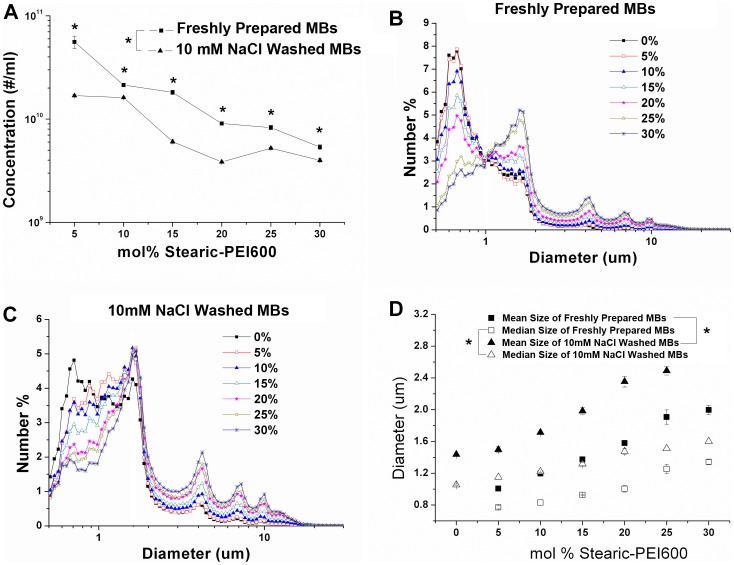
Concentration and size distribution of fresh prepared and washed MBs.(A) Concentrations of freshly prepared and washed MBs with various amounts of Stearic-PEI600. (B) Size distribution of freshly prepared MBs with various amounts of Stearic-PEI600. (C) Size distribution of 10 mM NaCl washed MBs with various amounts of Stearic-PEI600. (D) Mean and median size of fresh prepared and 10 mM NaCl washed versus the Stearic-PEI600 fraction. The “freshly prepared” MBs were taken straight from the vial within 1 h of formation. The “washed” MBs were obtained by three cycles of flotation-centrifugation with infranatant exchange to remove the submicrometer bubbles.